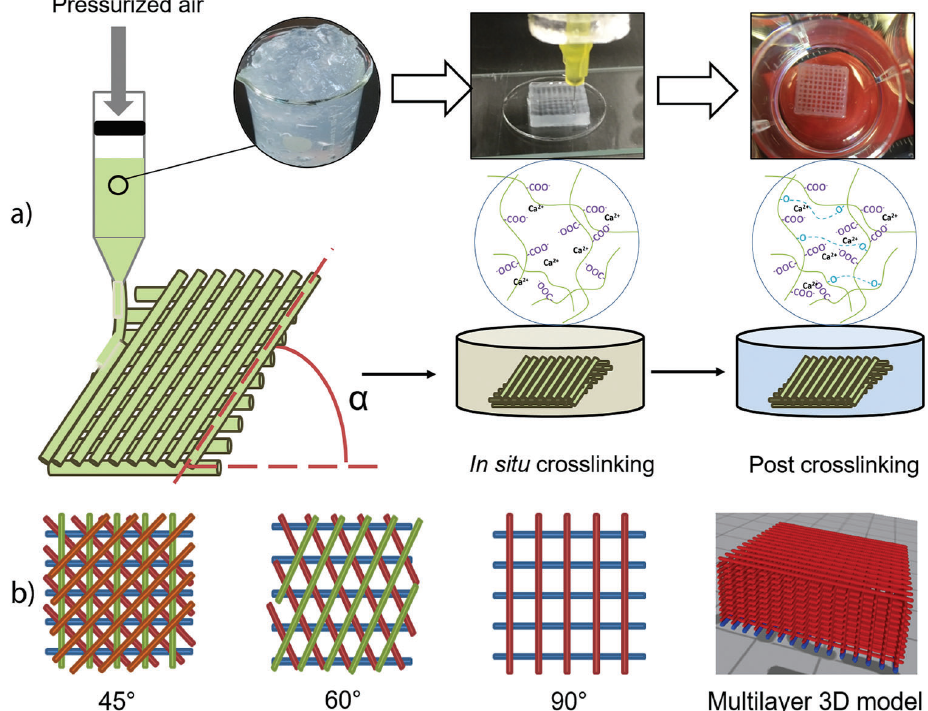
Figure 8. Illustration of 3D printing of CNF hydrogels: ( a ) schematic illustration of the printing process and the two-step crosslinking strategy; ( b ) printing patterns, top view of 45°, 60°, and 90° patterns, and 3D view of the 90° scaffold model. Adapted with permission from the authors of [115]. Copyright 2018 The Royal Society of Chemistry.